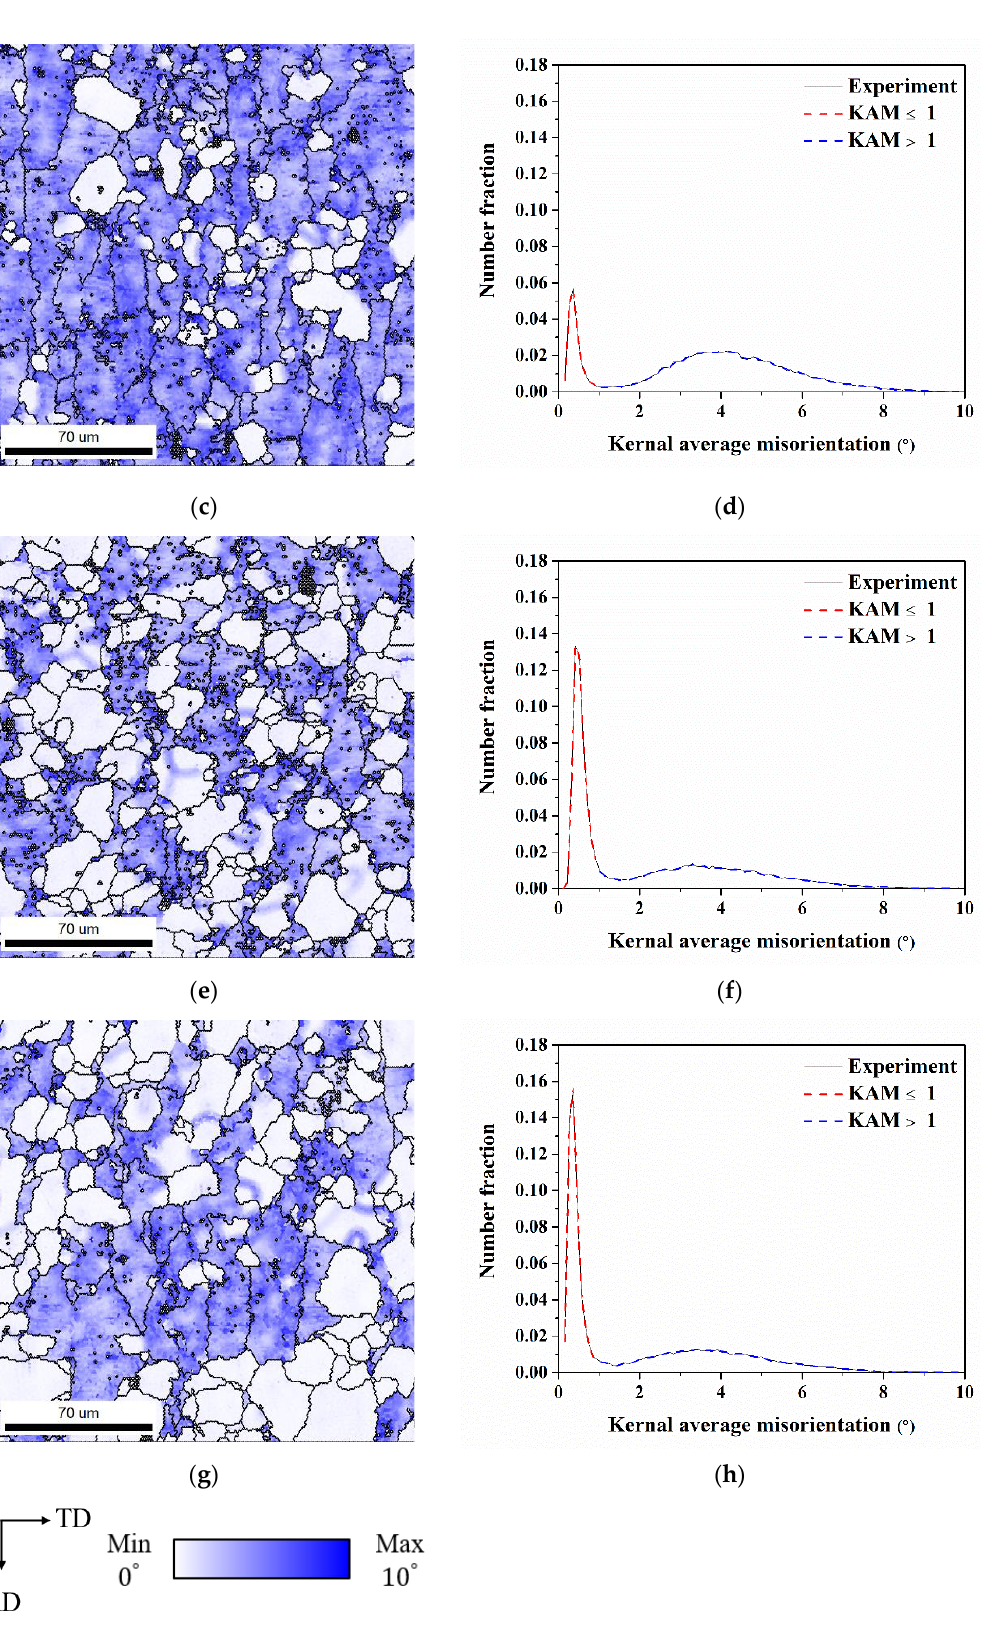
Figure 4. ( a , c , e , g ) KAM maps and ( b , d , f , h ) the corresponding distributions of KAM value in AA5151 alloy at 250 °C for ( a , b ) 0.5 h, ( c , d ) 1 h, ( e , f ) 2 h, and ( g , h ) 3 h.